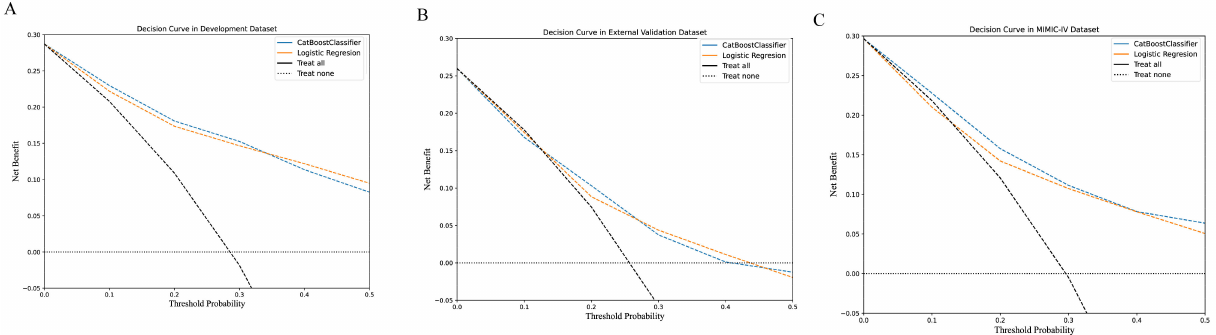
Figure 3. ( A ) The decision curves of logistic regression and the CatBoostClassifier models in the development dataset. ( B ) The decision curves of logistic regression and the CatBoostClassifier models in the validation dataset. ( C ) The decision curves of logistic regression and the CatBoostClassifier models in the MIMIC-IV dataset.